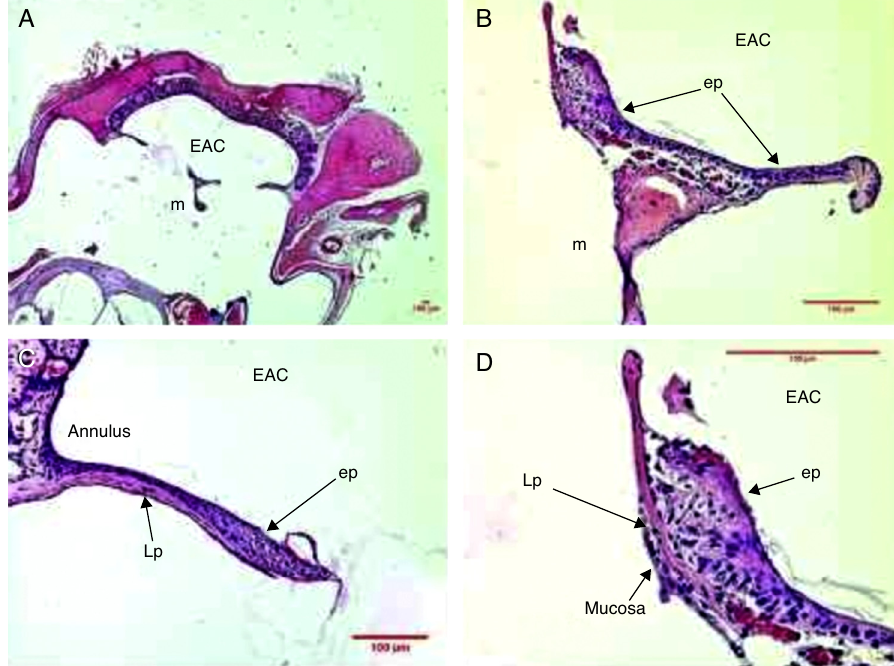
Figure 3 Histological section images of rat TM 3 days after traumatic perforation, stained with HE. EAC, external auditory canal; m, malleus handle; ep, epithelial layer; Lp, lamina propria; mucosa, mucosal layer. Image (A) shows a magnification of 20 × ; (B and C) 200 × and (D) 400 ×